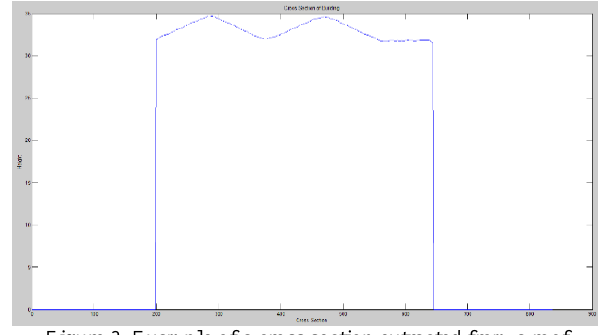
Figure 3. Example of a cross section extracted from a roof